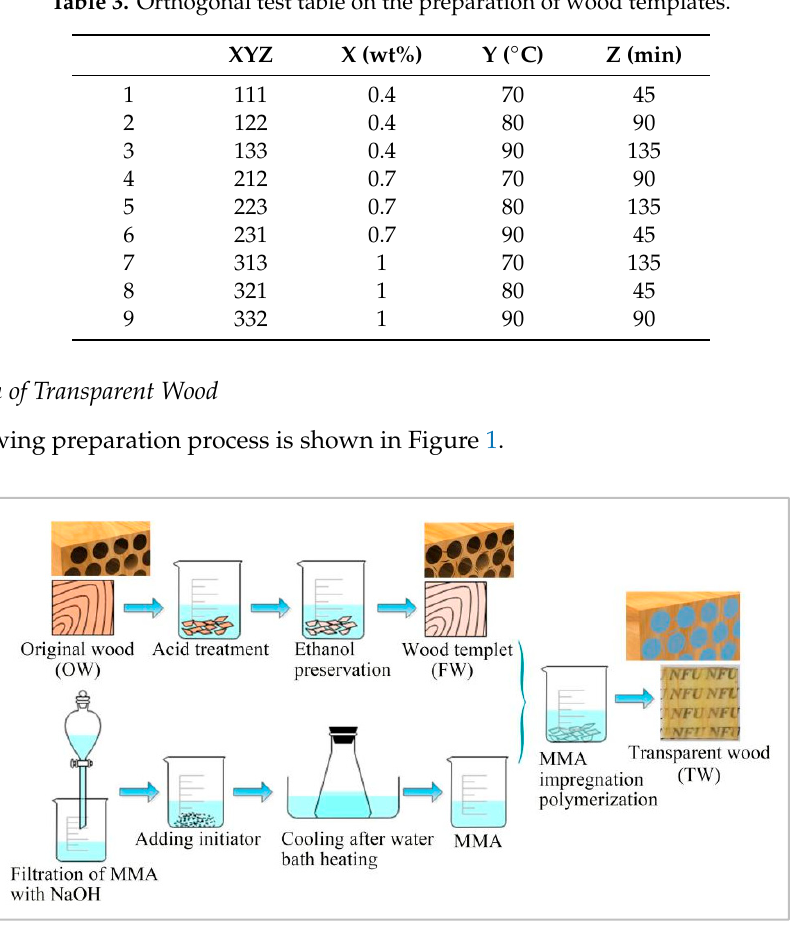
Figure 1. The main preparation process of transparent wood (TW).